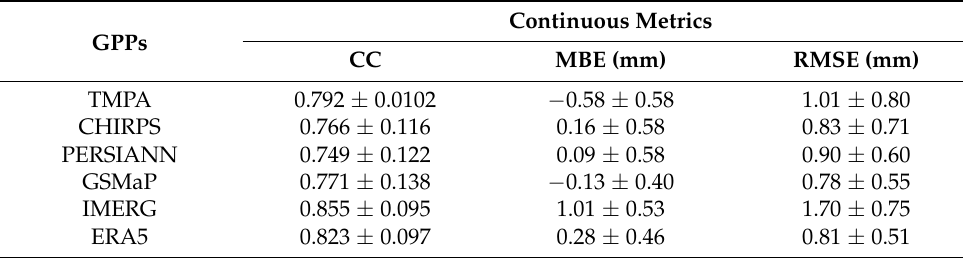
Table 4. Continuous metrics calculated from monthly average precipitations values of the GPPs and synoptic stations at the station